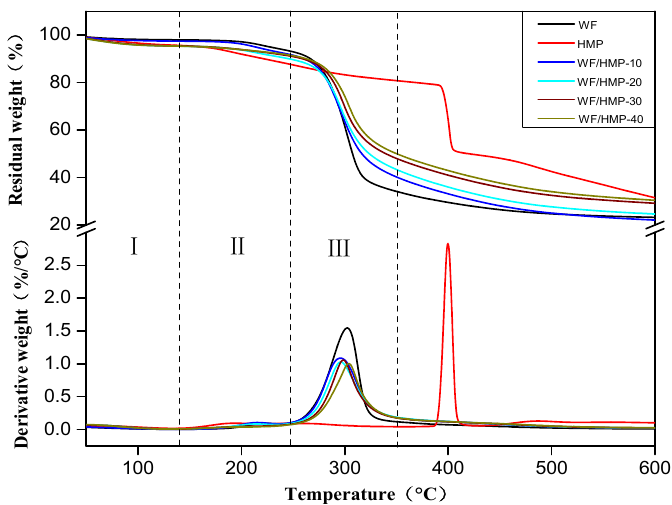
Figure 4. Thermo gravimetric (TG) and derivative thermo gravimetric (DTG) of the different adhesive samples.